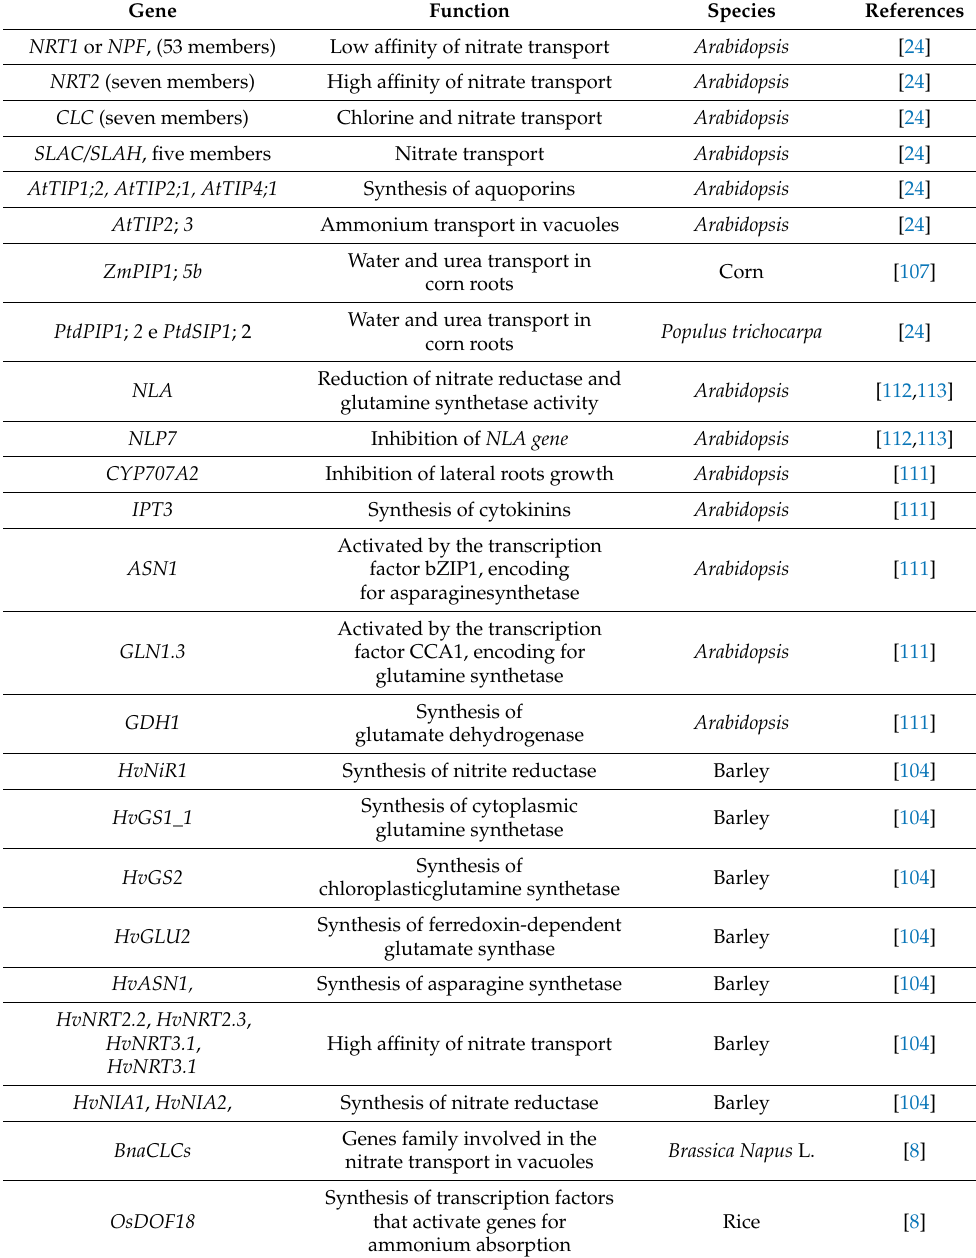
Table 1. Genes involved in N